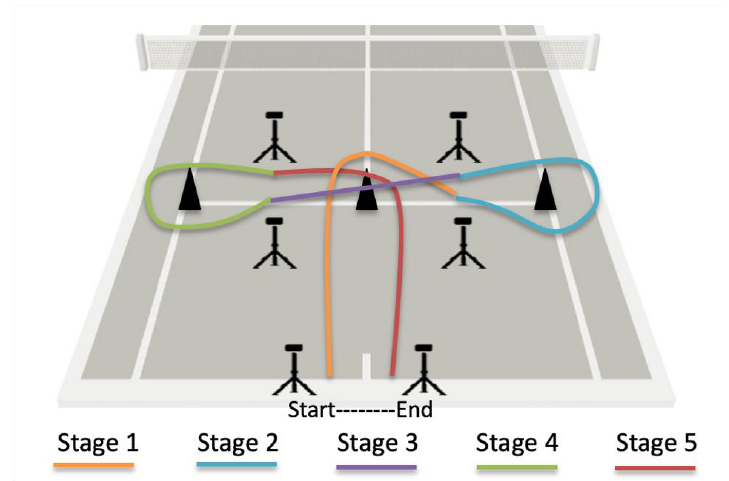
Figure 2. Stages of the agility wheelchair tennis test. Adapted from Sánchez-Pay & Sanz-Rivas, 2019. Reprinted with